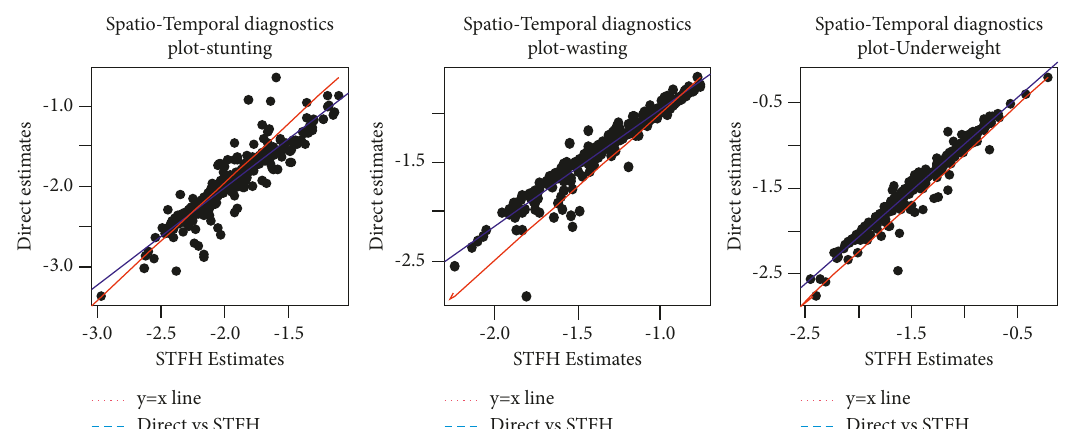
Figure 1: Bias diagnostic plot with y � x line (red line) and regression line (blue line) for stunting, wasting, and underweight: Model-based STFH estimates versus direct estimates.